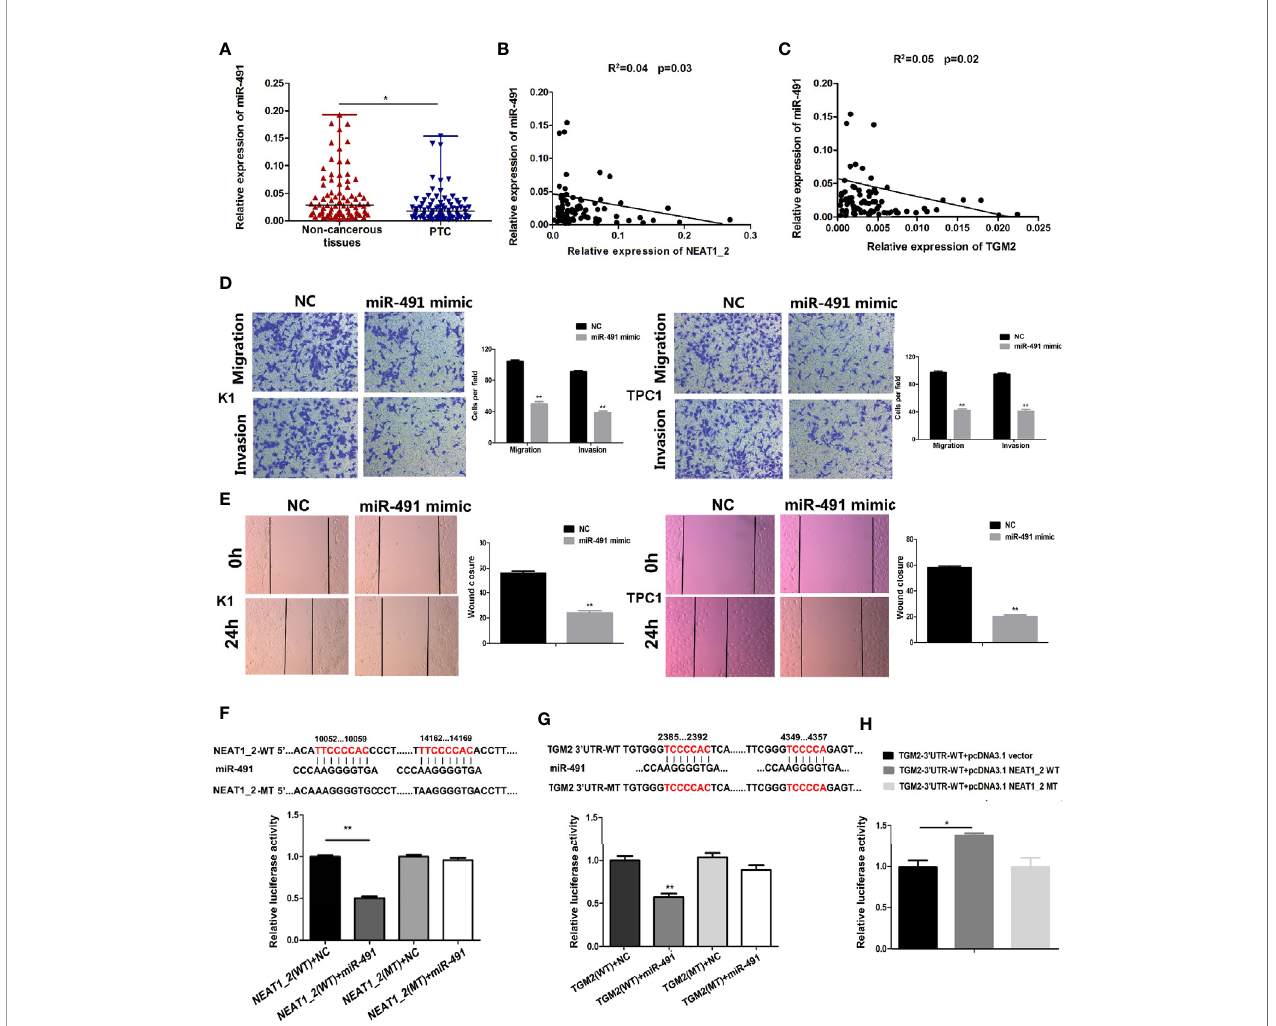
FIGURE 5 | miR-491 inhibited PTC migration and invasion and could directly bind to NEAT1_2 and the 3 ′ UTR of TGM2. (A) The relative expression levels of miR-491 in 80 pairs of PTC tissues and adjacent non-cancerous tissues, as determined using qRT-PCR. The Wilcoxon signed-rank test was used to analyze the differences between the two groups; data are presented as the median with a range. *P < 0.05. (B) Pearson ’ s correlation analysis was performed to analyze the correlations between NEAT1_2 and TGM2 expression in PTC tissues (R 2 = 0.056, P = 0.042). (C) Pearson ’ s correlation was performed to analyze the correlations between miR-491 and TGM2 expression in PTC tissues (R 2 = 0.05, P = 0.029). (D) Transwell assays were used to evaluate the migration and invasion in PTC cells after transfection with miR-491 mimics or NC. Data are presented as the mean ± S.D., as analyzed using an independent samples t-test. **P < 0.01 versus NC. (E) A wound healing assay was applied to analyze the migration capacity in PTC cells after transfection with miR-491 mimics or NC. All data are presented as the mean ± S.D. (F) The predicted miR-491 binding sites in NEAT1_2 ( NEAT1_2 -Wt) and the designed mutant sequence ( NEAT1_2 -Mt) are indicated. HEK 293T cells were transfected with NEAT1_2 -Wt, NEAT1_2 -Mt, and the indicated miRNAs, and then a luciferase reporter assay was conducted. Data are presented as the mean ± S.D., as analyzed using an independent samples t-test. **P < 0.01 versus NEAT1_2 -Wt+NC. (G) The predicted miR-491 binding sites in the 3 ′ -UTR region of TGM2 ( TGM2 -3 ′ UTR-Wt) and the designed mutant sequence ( TGM2 -3 ′ UTR-Mt) are indicated. HEK 293T cells were transfected with TGM2 -3 ′ UTR-Wt or TGM2 -3 ′ UTR-Mt and the indicated miRNAs, and then a luciferase reporter assay was conducted. Data are presented as the mean ± S.D., as analyzed using an independent samples t-test. **P < 0.01 versus TGM2 -3 ′ UTR-Wt+NC. (H) TGM2 -3 ′ UTR-Wt was cotransfected with vectors pcDNA3.1, pcDNA3.1-NEAT1_2 Wt, and pcDNA3. 1-NEAT1_2 Mt, respectively, and then a luciferase reporter assay was conducted. Data are presented as mean ± S.D., as analyzed using an independent samples t-test. **P < 0.01 versus TGM2 -3 ′ UTR-Wt+pcDNA3.1